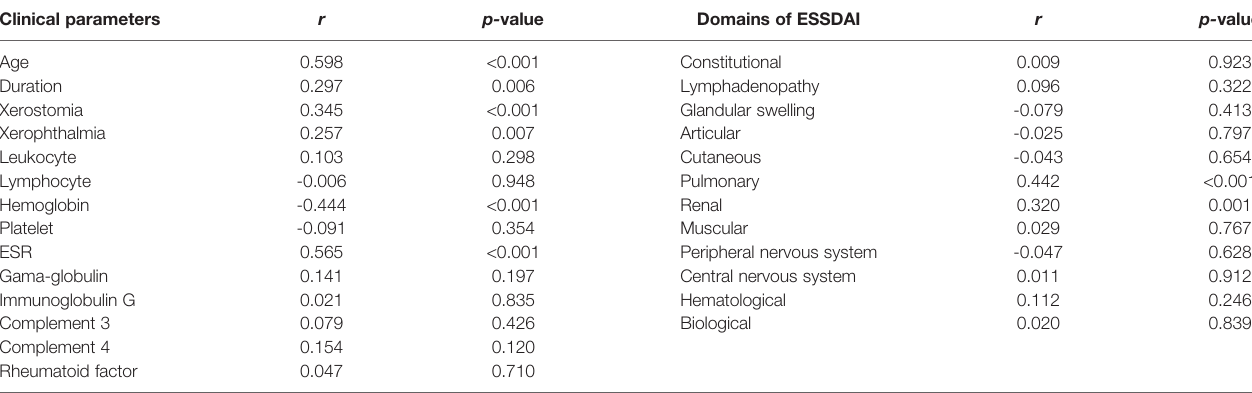
TABLE 4 | Correlations between HE4 and characteristics of patients with pSS. Clinical parameters